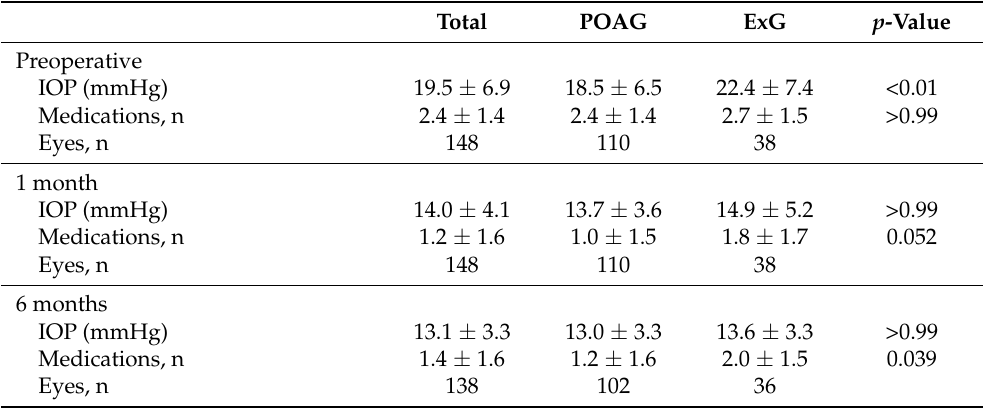
Table 2. Intraocular pressure and the number of glaucoma medications before surgery and at the postoperative follow-up